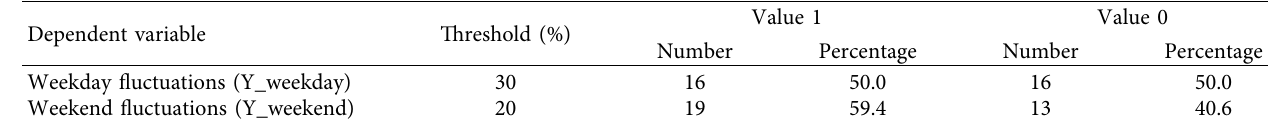
Figure 5: Spatial distribution of average weekend travel fow diferences. Table 1: Summary of dependent